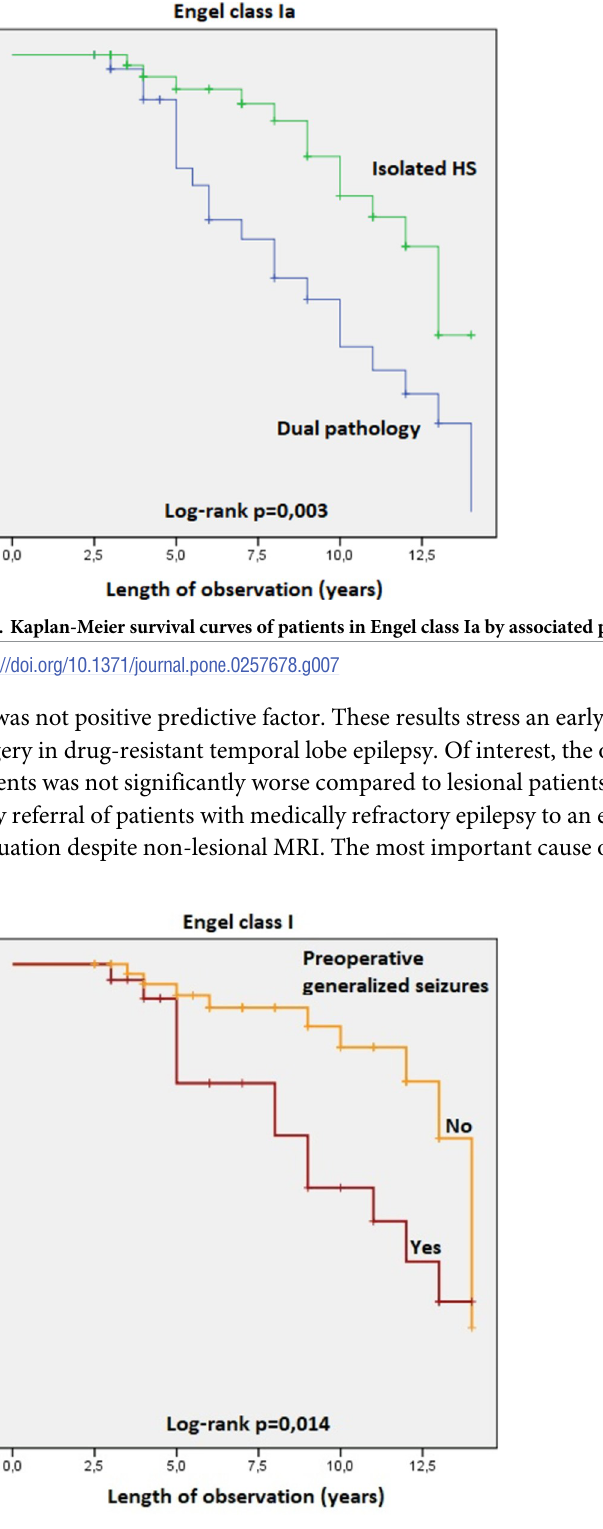
Fig 8. Kaplan-Meier survival curves of patients in Engel class I by seizure